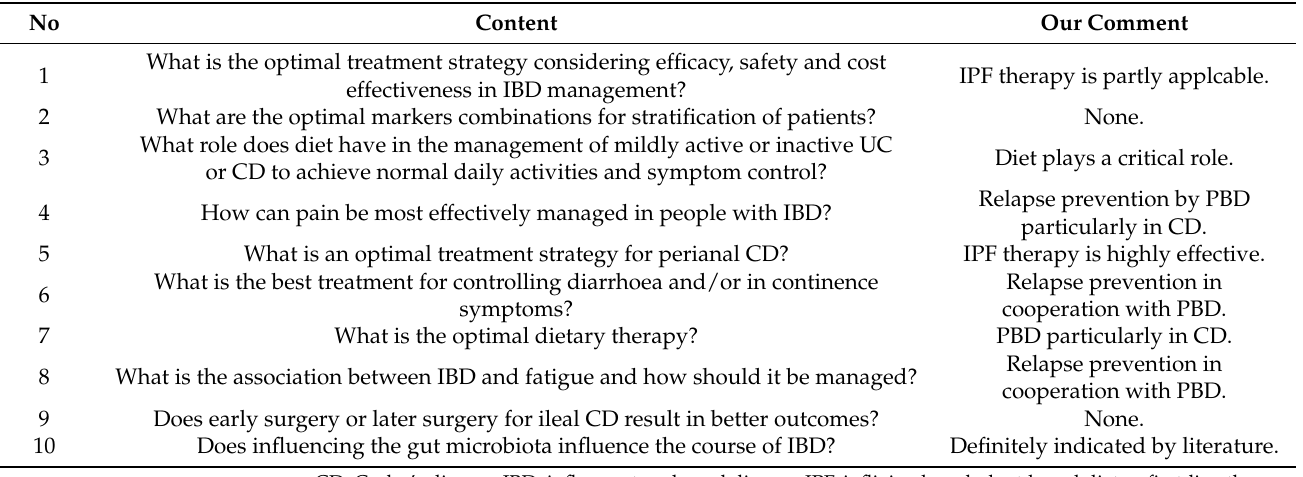
Table 1. Top 10 research questions in the treatment of inflammatory bowel